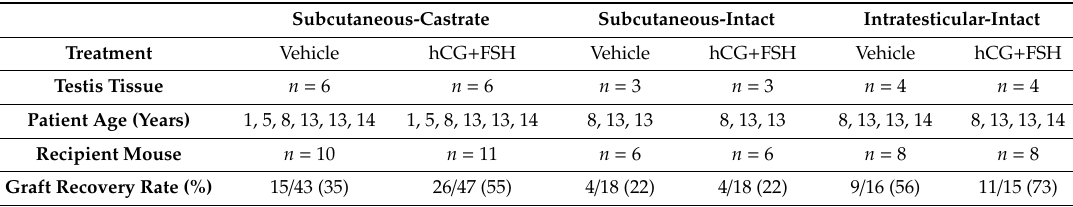
Table 2. Xenografting schedule and graft retrieval rates.